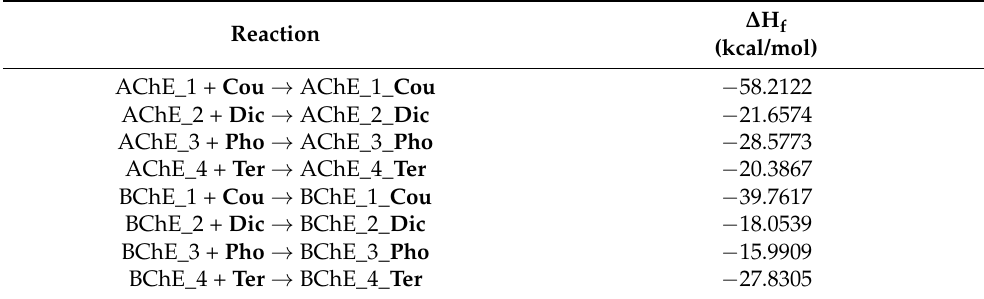
Table 1. Reaction enthalpy ( ∆ H f in kcal/mol) of organophosphorus pesticides ( Cou , Dic , Pho , and Ter ) binded with cluster models of enzymes (AChE and